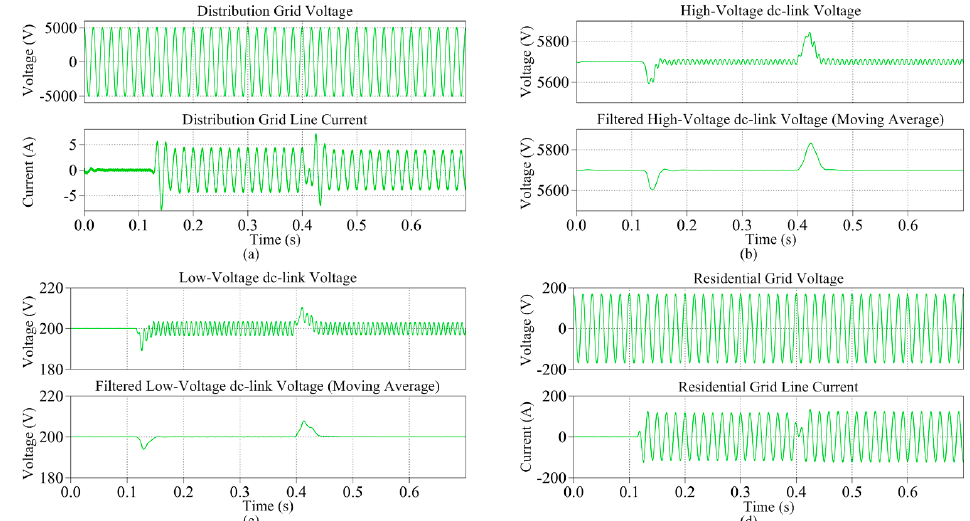
Figure 8. The major voltage and current waveforms in the various parts of the SST system under the worst-case load scenario ( i d * = 0 from 0 to 0.12 s, i d * = 118 from 0.12 to 0.4 s, and i d * = − 118 from 0.4 to 0.7 s); ( a ) Distribution grid voltage and current, ( b ) high-voltage-side dc-link voltage, ( c ) low-voltage-side dc-link voltage, ( d ) residential grid voltage and current.